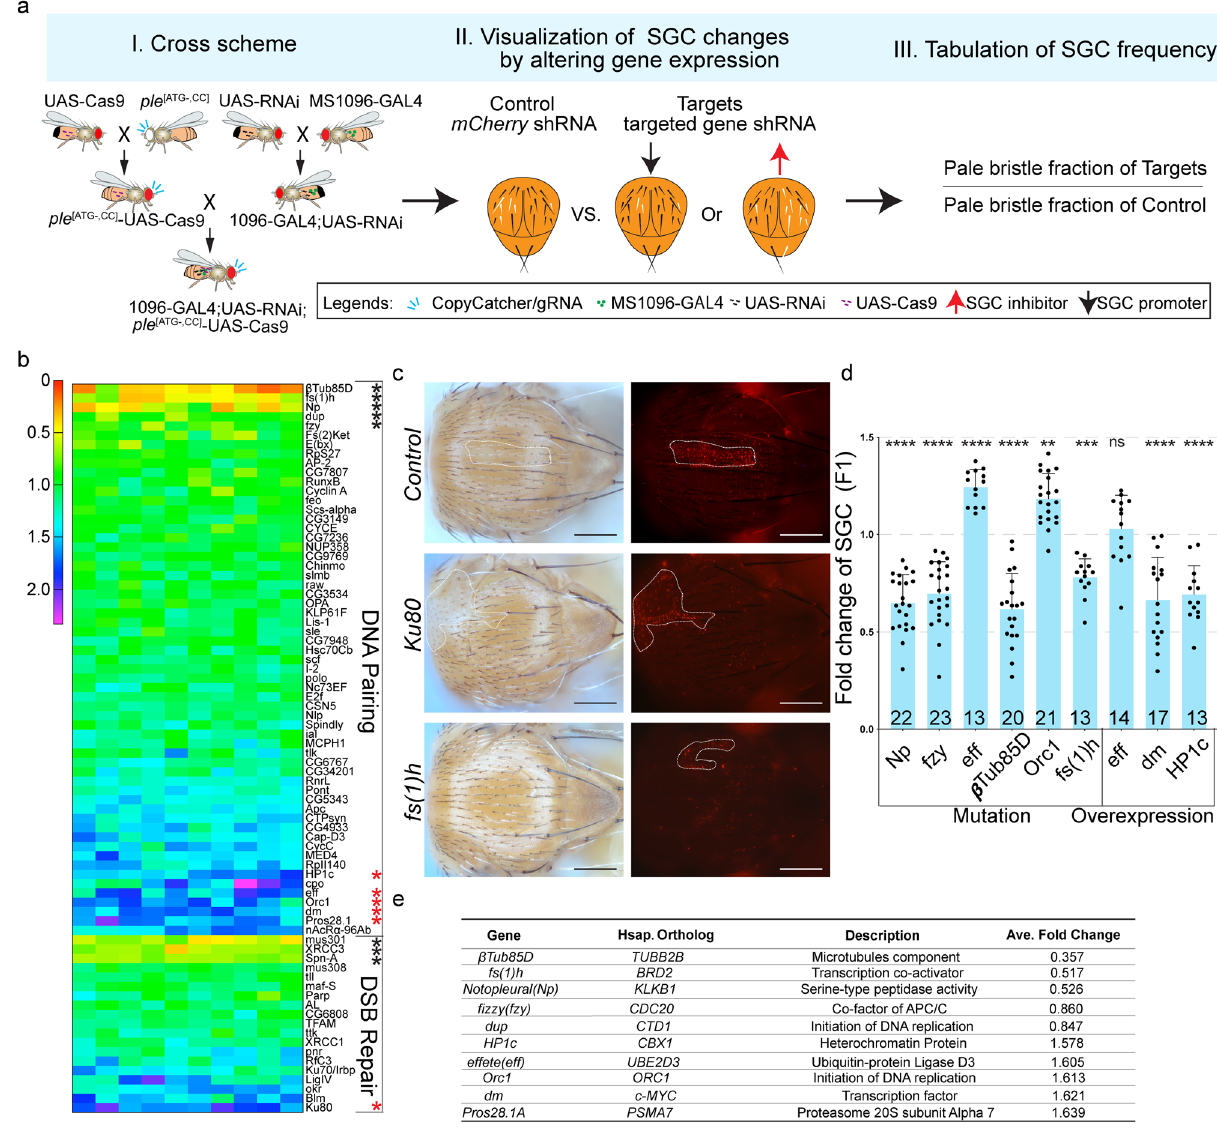
Fig. 3 Genetic screen for SGC modi fi ers using CopyCatcher. a Work fl ow of genetic RNAi screen using ple [ATG-,CC] . b Heatmap displays results for genes modulating ple [ATG-,CC] induced SGC. Values are shown as fold change of SGC frequency by normalizing the pale bristles on every single fl y to averaged control fl ies. The value is calculated by dividing the SGC frequency with knock-down indicated genes by the average control SGC frequency obtained with an shRNA targeting mCherry . Scores less than 1 indicate genes promoting SGC (black stars indicate the top SGC promoters) while scores greater than 1 represent inhibitors of SGC (red stars indicate the top SGC inhibitors). c Examples of knocking down SGC inhibitor ( Ku80 ) and promoter ( fs(1)h ) (Ten independent fl ies were imaged as showed in Supplementary Fig. 6). The dominant SGC patches with light thoracic pigmentation and pale bristles are delineated with dotted white lines. Scale bars indicate 100 pixels. d Validation of the top SGC modulating candidates in individuals carrying either heterozygous loss of function alleles or MS1096-GAL4 and UAS over-expression constructs. Each dot represents the relative fraction of pale bristles scored for a single fl y and the number of fl ies counted was labeled at the bottom of each bar. P values were: Orc1 = 0.0011 (**, one-way ANOVA), fs(1)h = 0.0006 (***, one-way ANOVA), eff = 0.9969 (ns, one-way ANOVA), and others are <0.0001 (****, one-way ANOVA). Error bars indicate mean ± S.D. e Key gene information for the top SGC modi fi ers identi fi ed by the ple [ATG-,CC] CopyCatcher RNAi screen (in panel ( b )). Raw data for ( d ) is provided as a Source Data fi